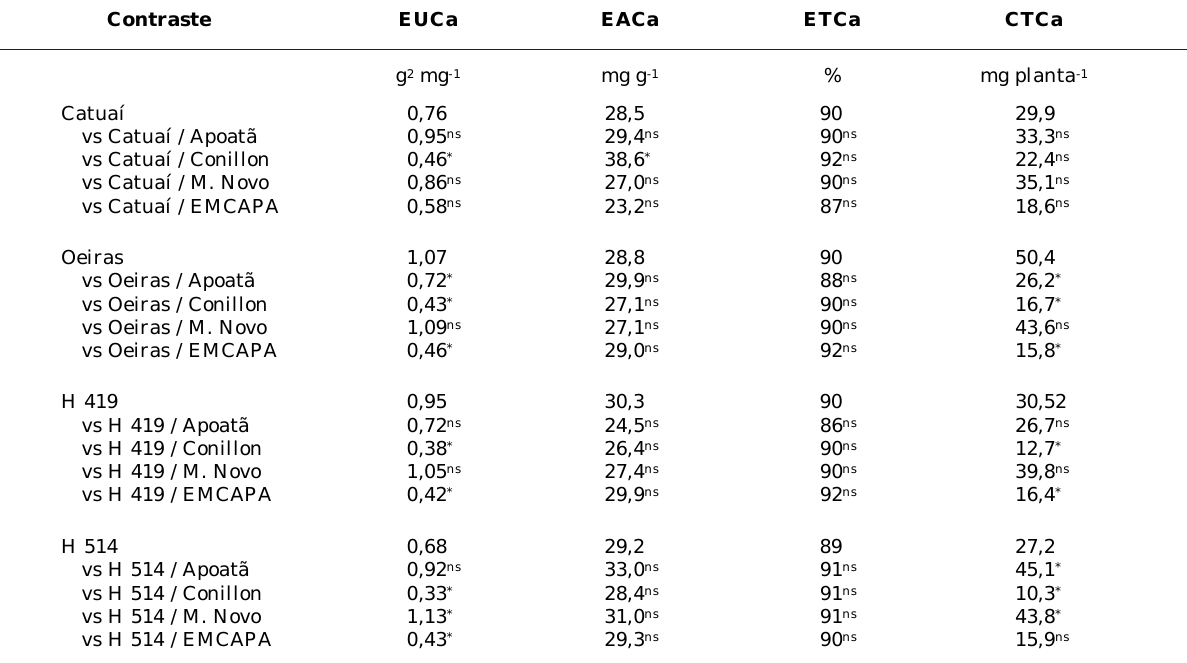
* e ns : contrastes significativos e não-significativos, respectivamente, pelo teste “t” de Student a 5 %.